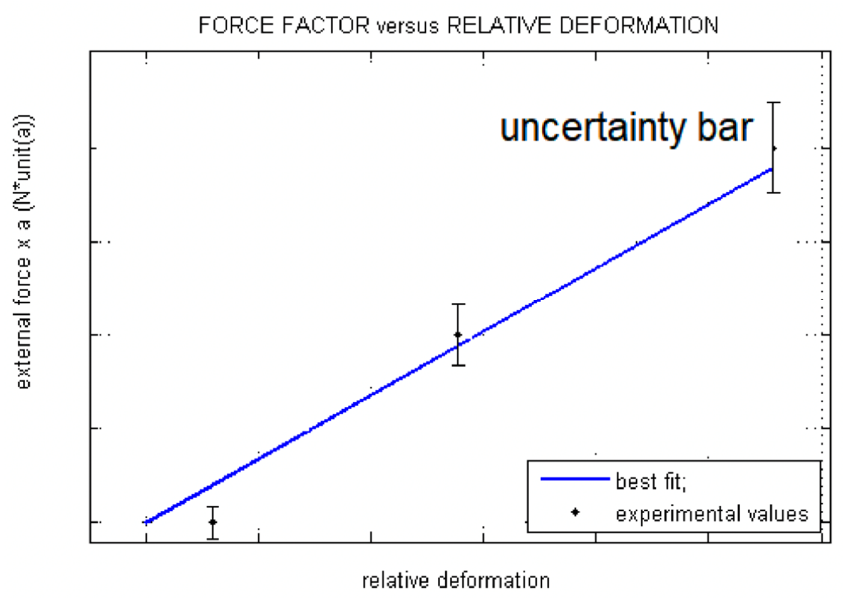
Figure 17. Linear regression graph of force factor by relative strain.